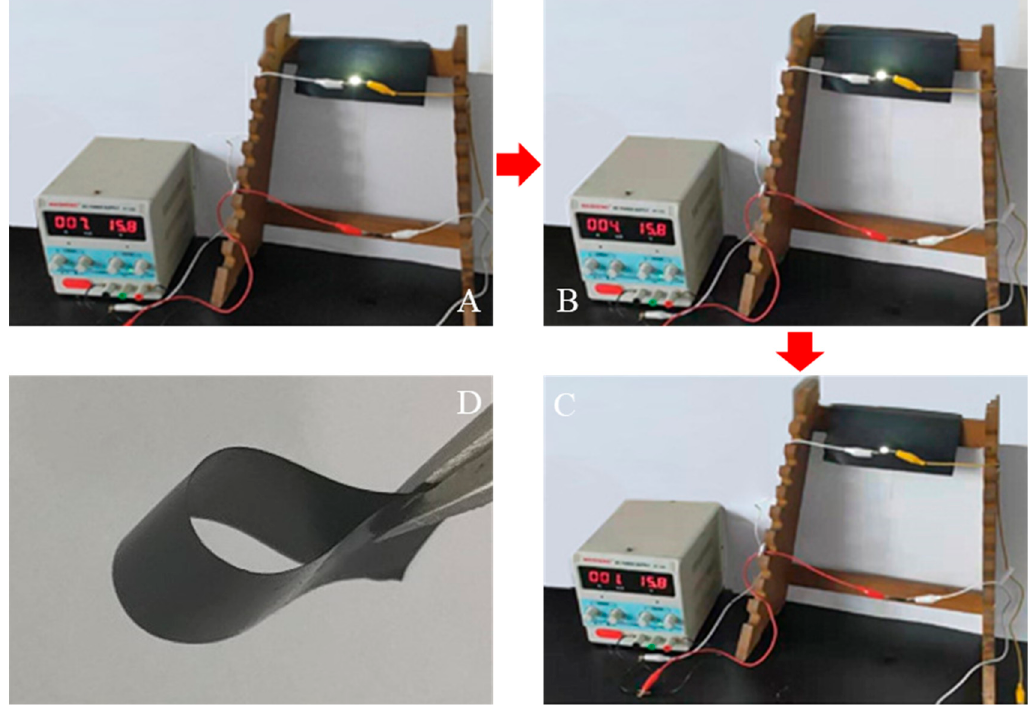
Figure 8. ( A ) 0 s, ( B ) 60 s, and ( C ) 170 s of the LED lamp bead brightness picture after dripping, respectively. ( D ) Flexible display of the SF/GrP/BD